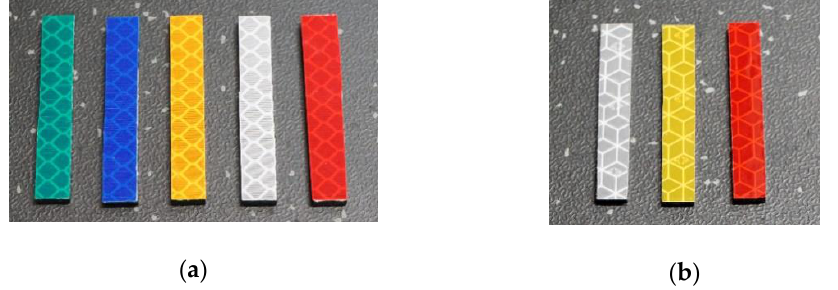
Figure 2. The used retroreflective foils in a size configuration of 0.7 cm × 4.7 cm, ( a ) 3M retroreflective